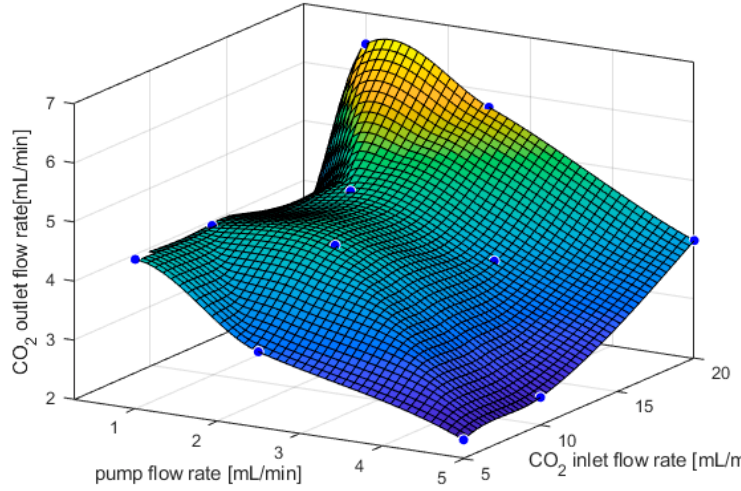
Figure 6. Interpolating fit of experimental CO 2 outlet results obtained at J = 100 mA/cm 2 for different CO 2 inlet and pump flow rates. The blue points are the experimental data.